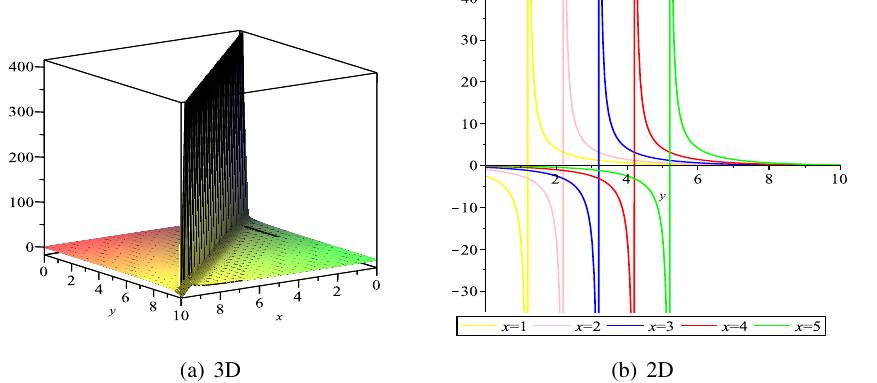
Fig. 6 The singular soliton solution (91) for k 1 = 0 . 5 , k 2 = − 0 . 5 , k 3 = 0 . 5 , c 2 = − 1 . 2 , δ = − 1 . 5 , α =